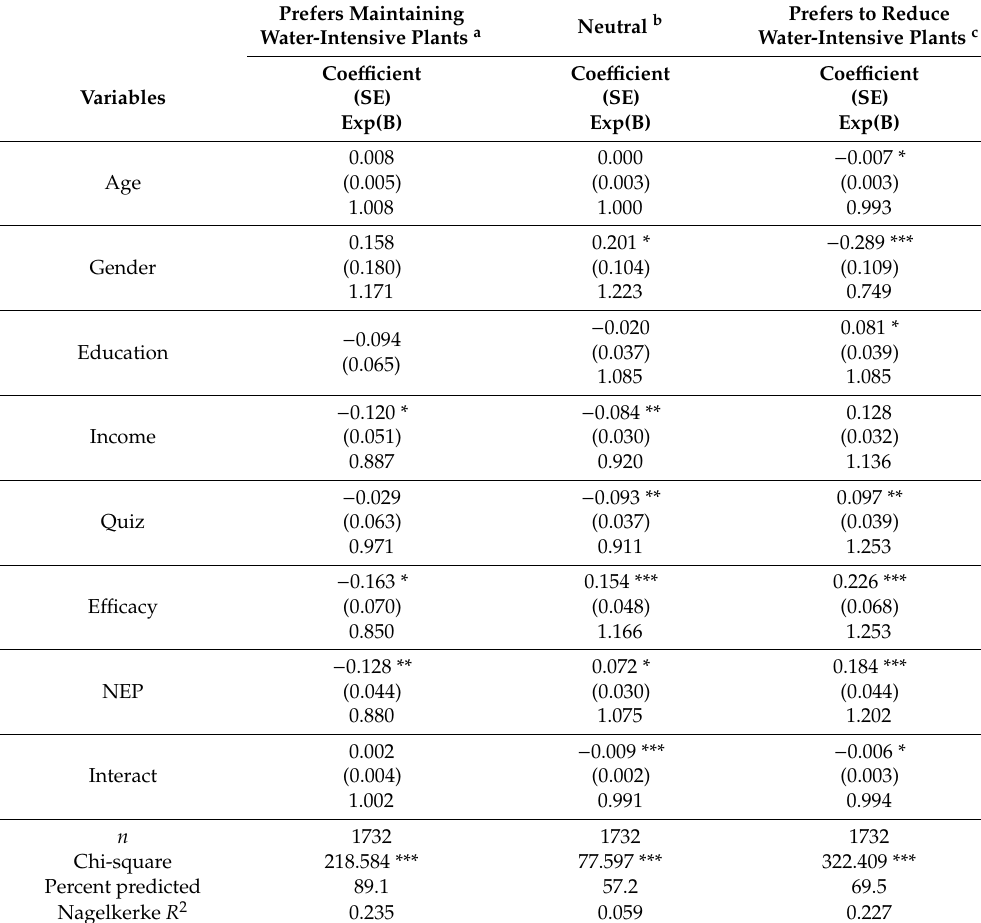
Table 6. Logistic regression estimates for the food–environment tradeo ff